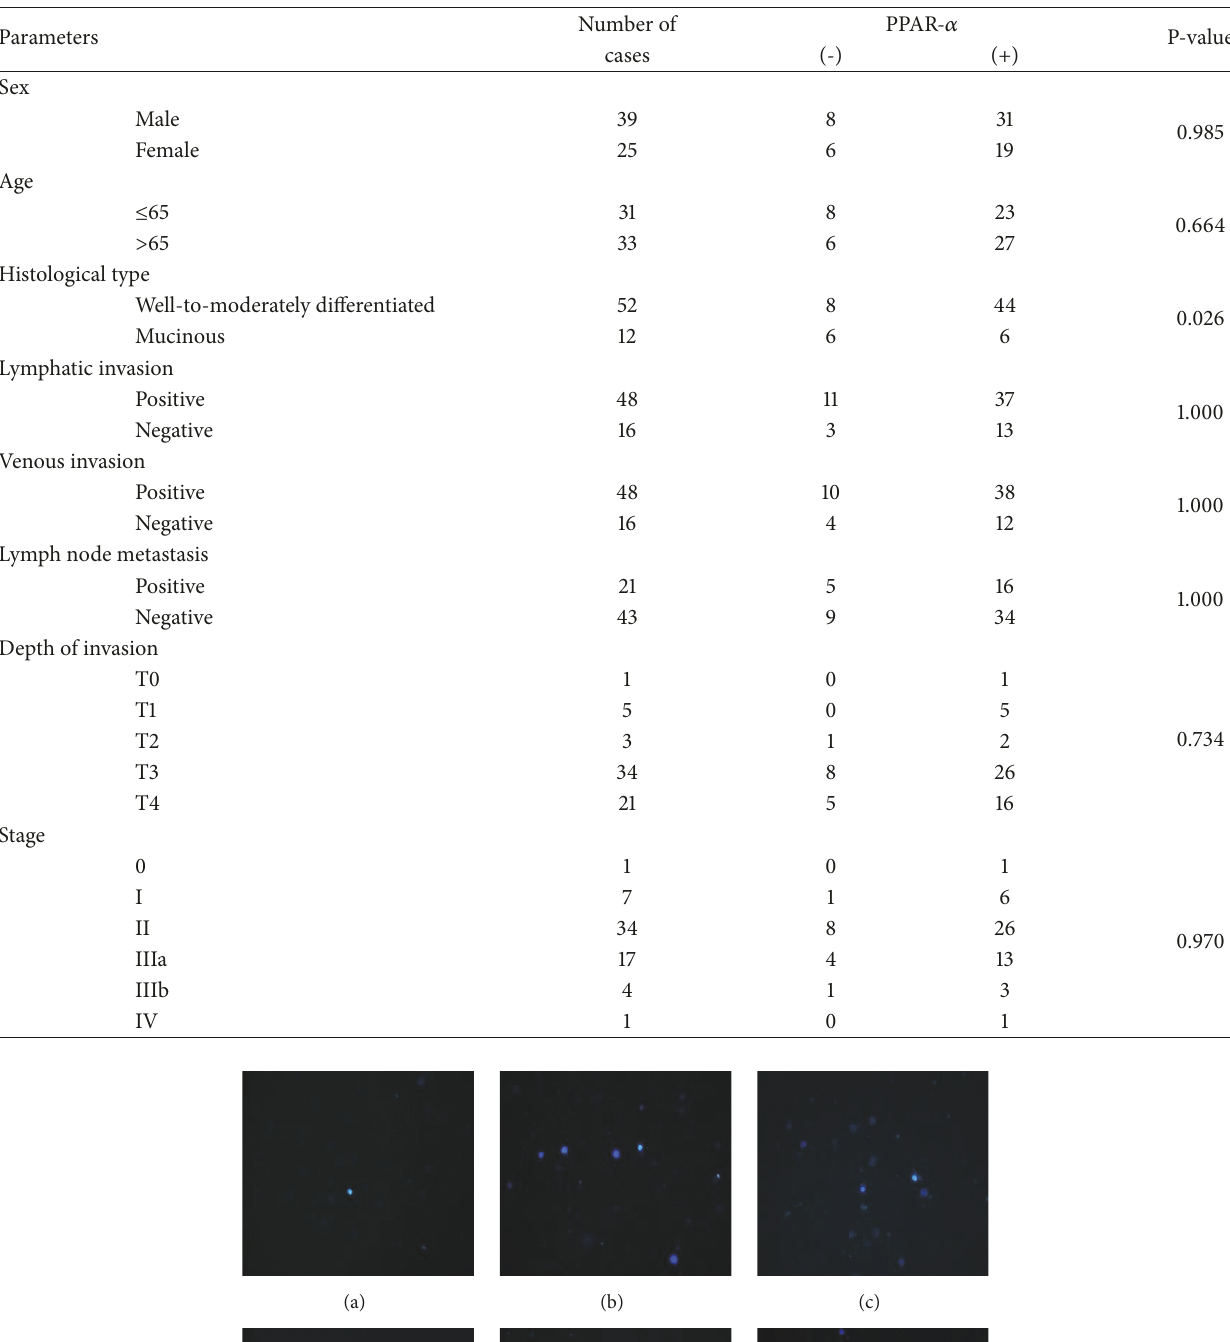
Table 2: The relationship of PPAR- 𝛼 expression to clinicopathologic parameters of colorectal carcinoma (n=64).